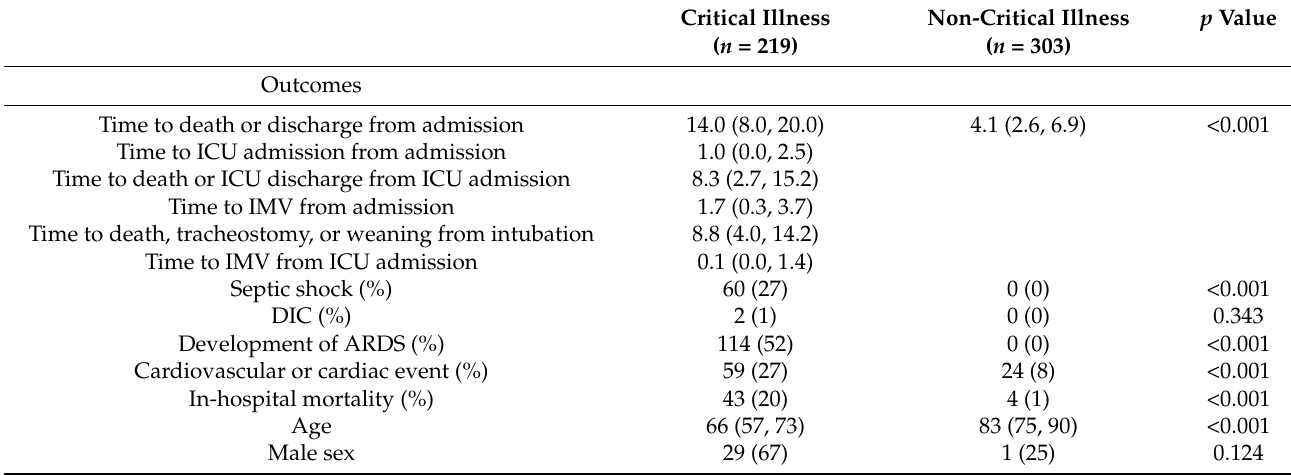
Table 2. Clinical outcomes among all patients hospitalized with COVID-19 pneumonia.